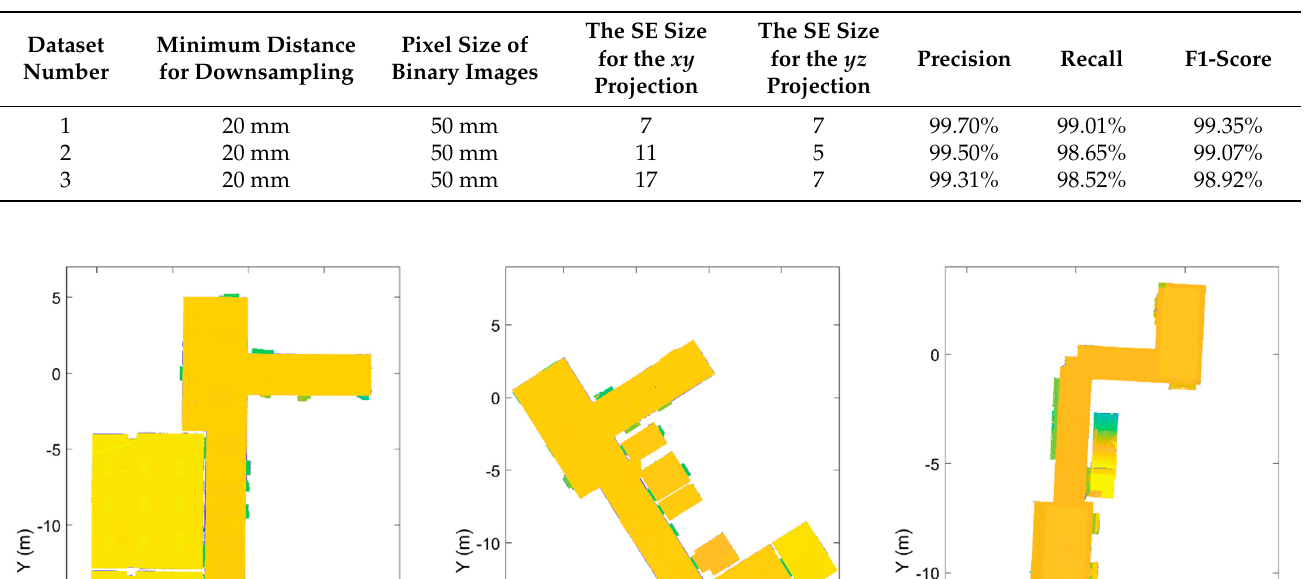
Table 1. The values of the key variables used and the quality indices for the output point clouds.